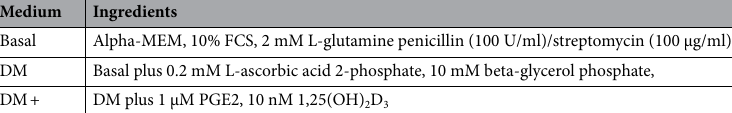
Table 1. Ingredients of culture medium for osteoblasts, osteoclasts and